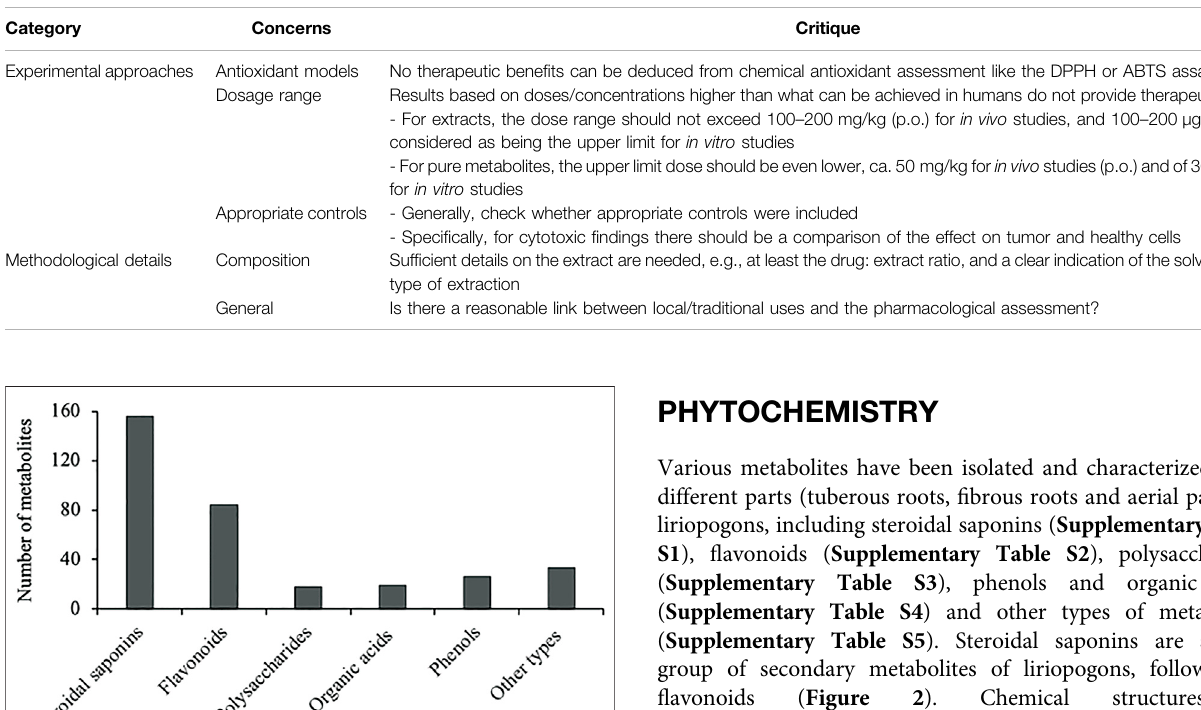
( Supplementary Table S4 ) and other types of metabolites ( Supplementary Table S5 ). Steroidal saponins are a core group of secondary metabolites of liriopogons, followed by fl avonoids ( Figure 2 ). Chemical structures of pharmacologically active metabolites are shown in Table 2 . As main bioactive metabolites, the chemical structures of steroidal S2 and Supplementary Figure S2 .